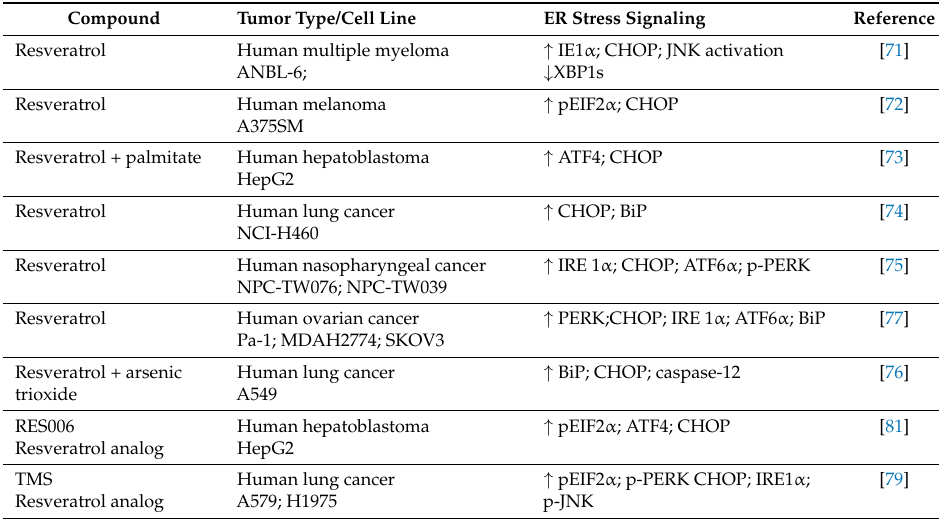
Table 2. Resveratrol and its analogues with ER stress-mediated anticancer